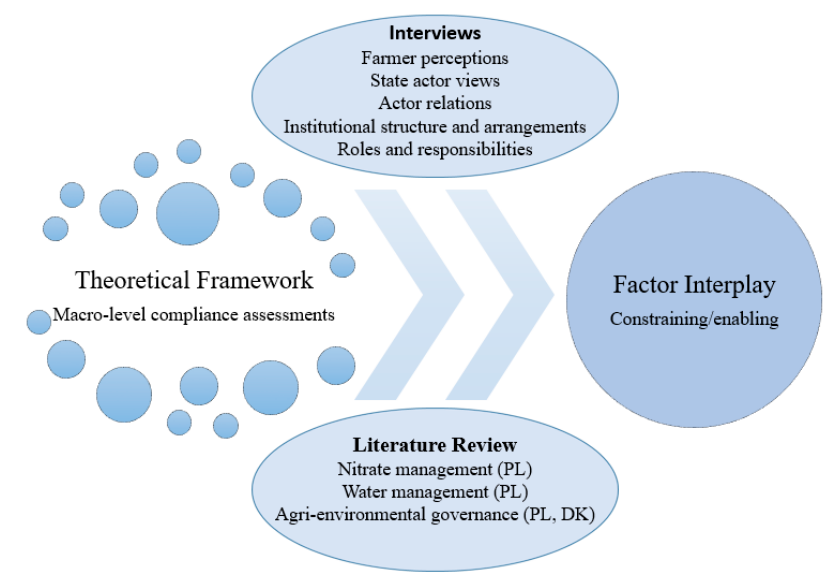
Figure 3. Phase 1: Factor interplay. Water 2020 , 12 , x FOR PEER REVIEW